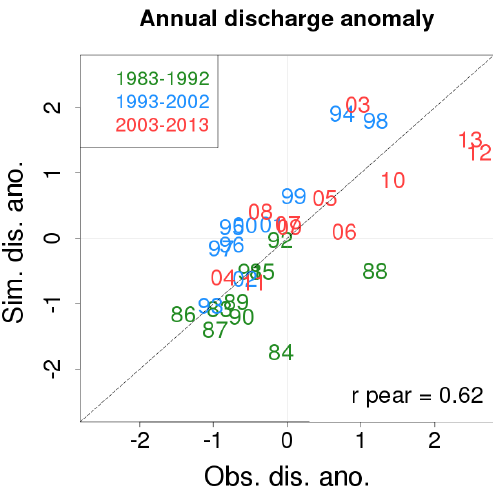
Figure 5. Scatter plot of the anomaly in the simulated peak dis- charge (Y) versus the anomaly in the observed peak discharge (X). The last 2 digits of the year are indicated for each dot (i.e. 12 =